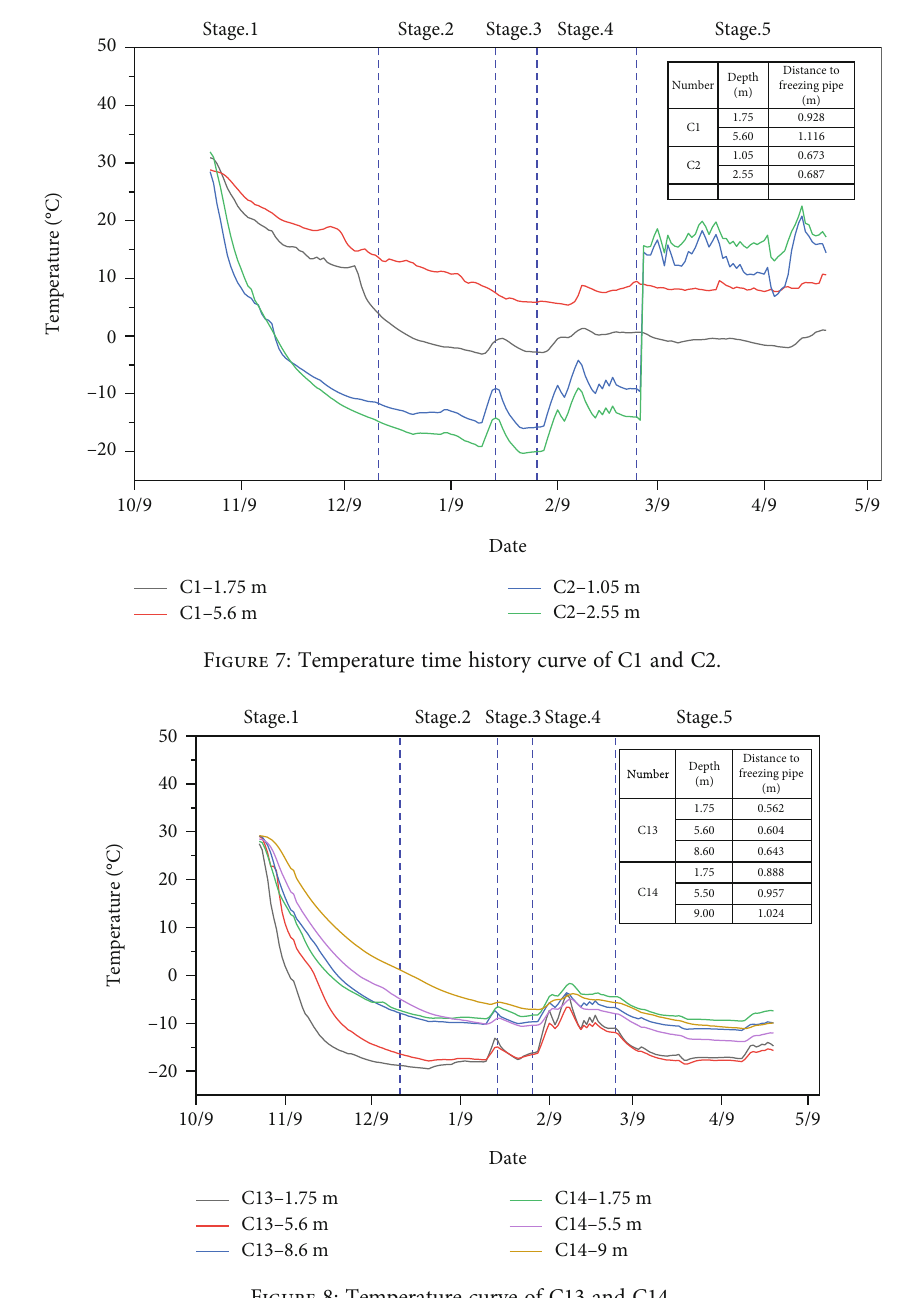
Figure 8: Temperature curve of C13 and